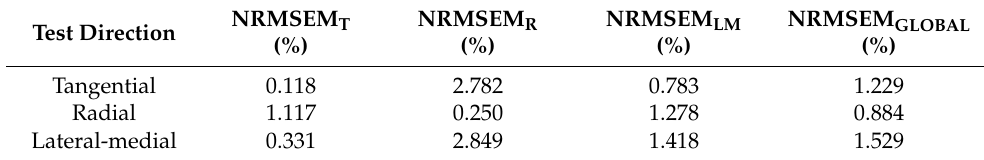
Table 5. NRMSE of M mean (results expressed in %).